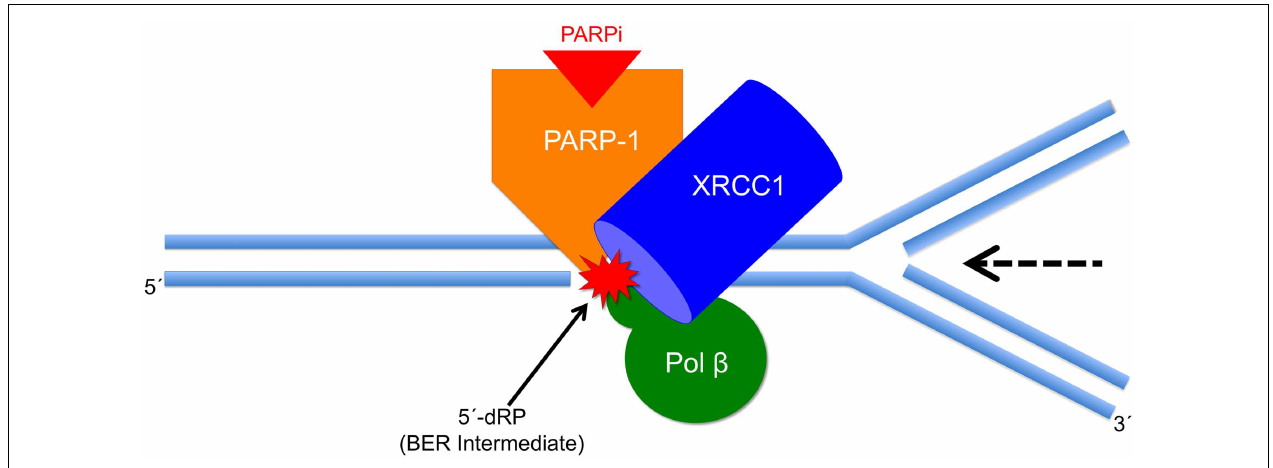
indicated by the arrow and becomes stalled at the protein complex.We propose that stalling leads to replication fork collapse, DSB formation, and cell